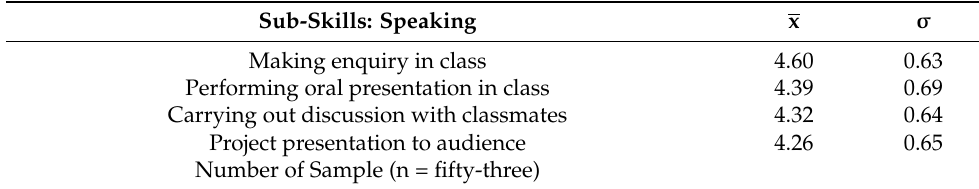
Table 7. The Significance in the Enhancement of Speaking